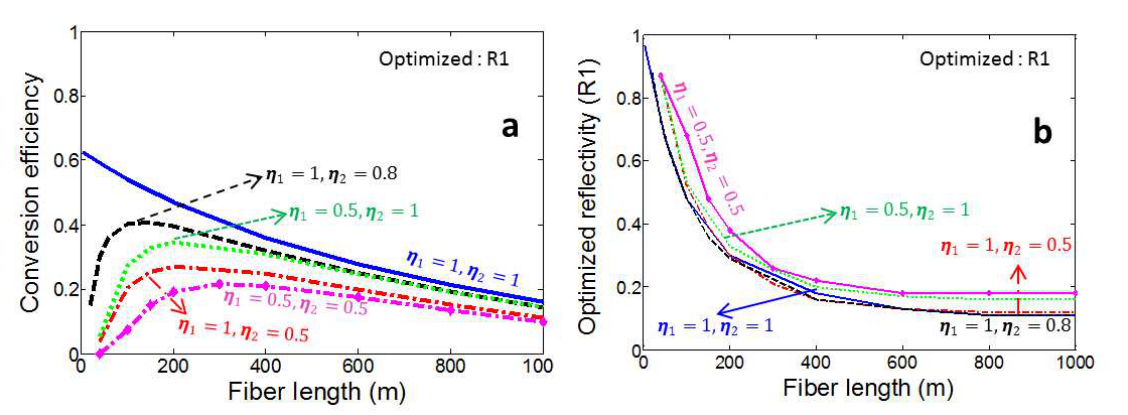
Figure 10. ( a ) Simulations of conversion efficiency vs. DCRF length with optimized output couplings for different re-launch efficiencies ( η out-coupling end R1 for different re-launch efficiency corresponding to Figure 10a. In the HR end, R = 1 in all 2